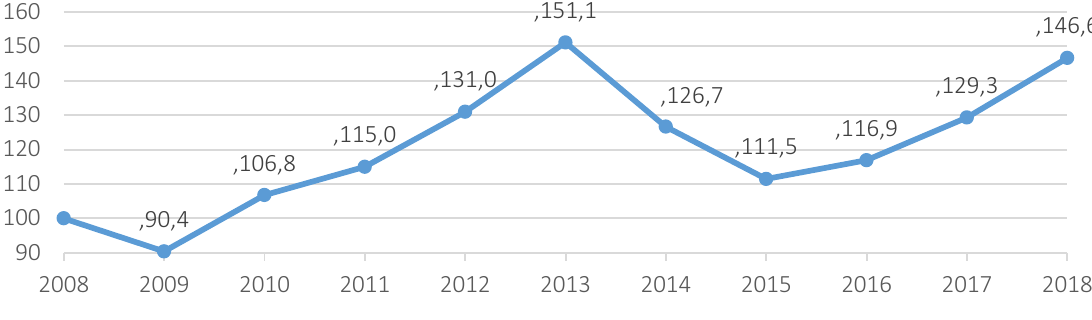
Figure 6. Disposable income index in Odesa region in 2008–2018, percent (2008 = 100 %)